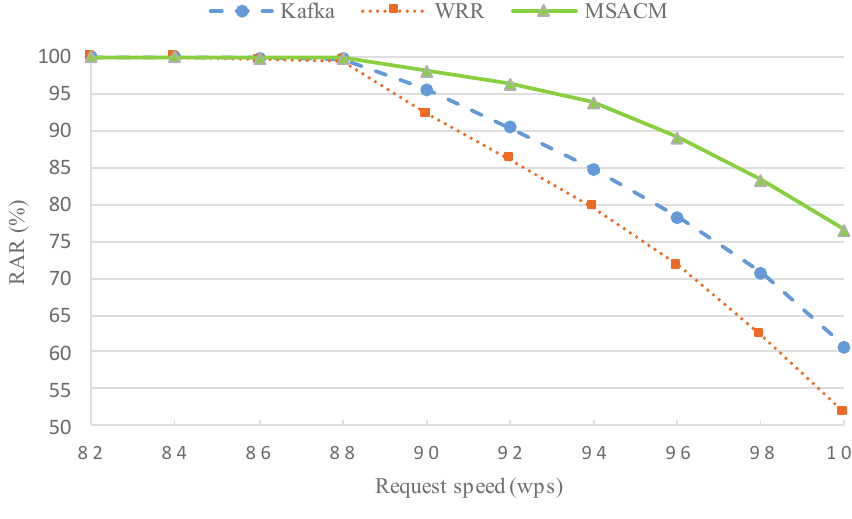
Figure 7. RAR with different request